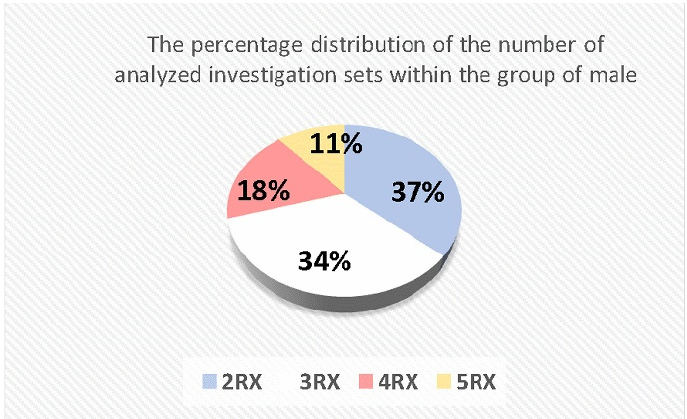
Figure 2. The percentage distribution of the number of analyzed investigation sets within the group of males. Out of the 44 sets of investigations, 37% had 2 sets of investigations done, 34% had 3 sets, 18% had 4 sets, and 11% had 5 sets (in the diagram 2RX, 3RX, 4RX, and 5RX represents the number of sets of radiological investigations).